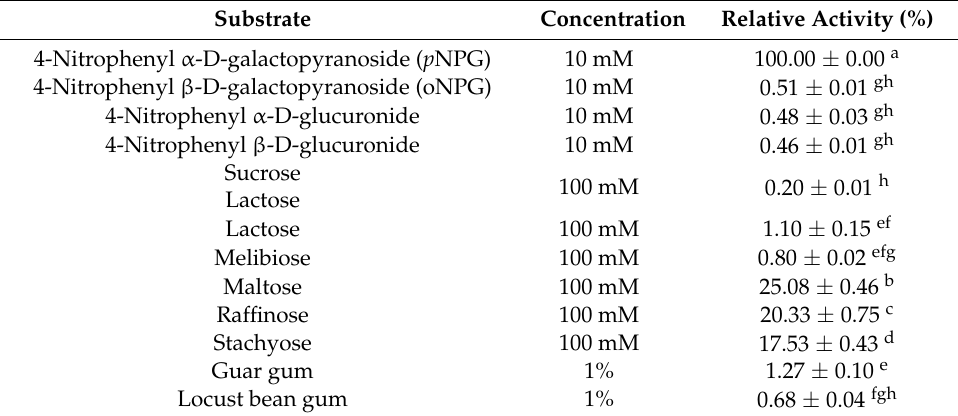
Table 5. Substrate specificity of ORG.